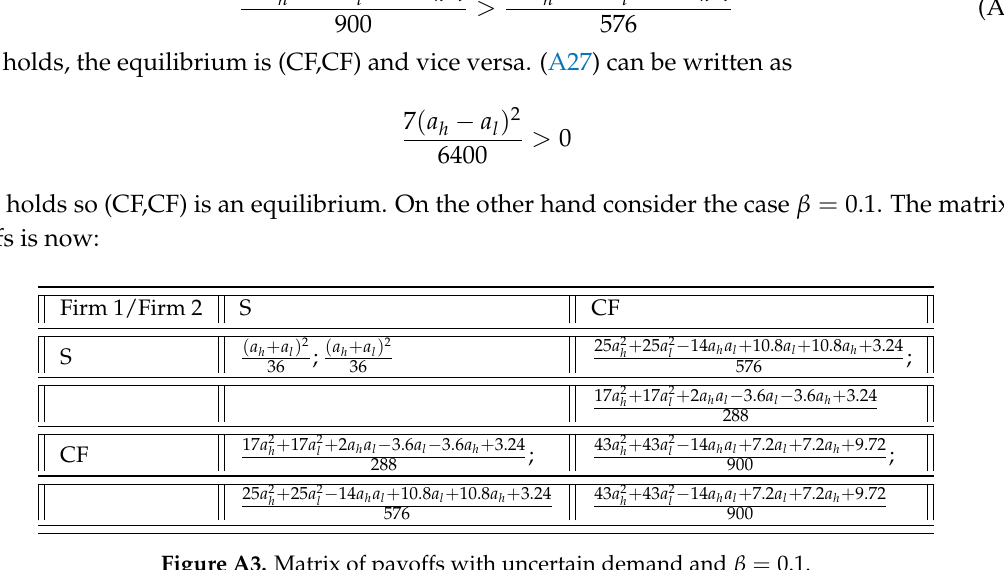
Figure A3. Matrix of payoffs with uncertain demand and β =